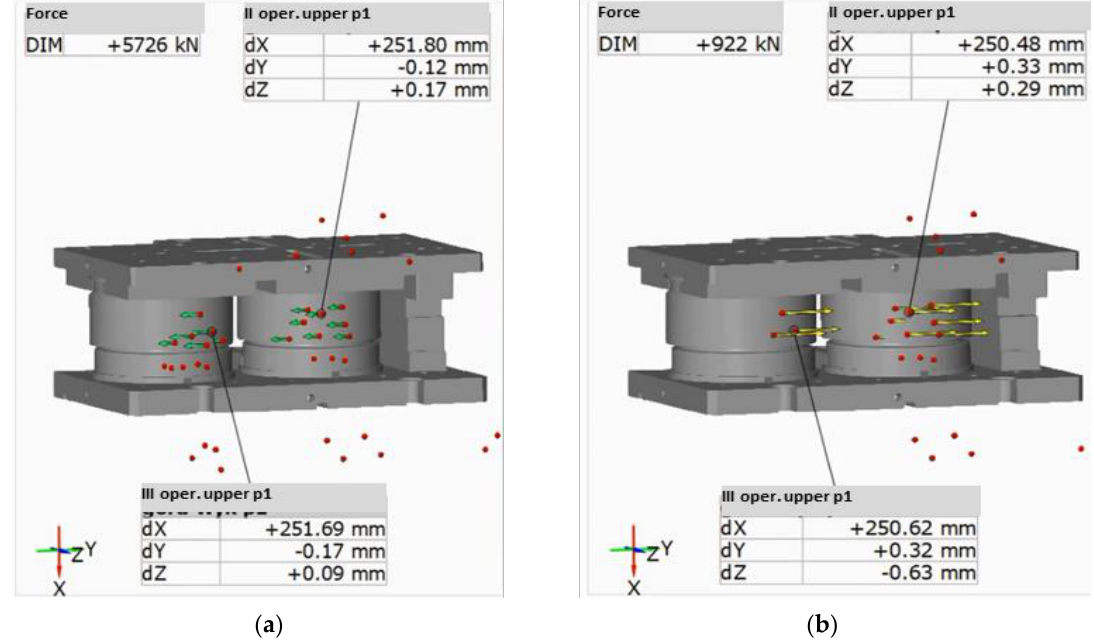
Figure 8. Vectors of upper insert displacements: ( a ) before reaching the lower stroke position (dx 251.69), ( b ) after reaching the lower stroke position (dx 250.62).